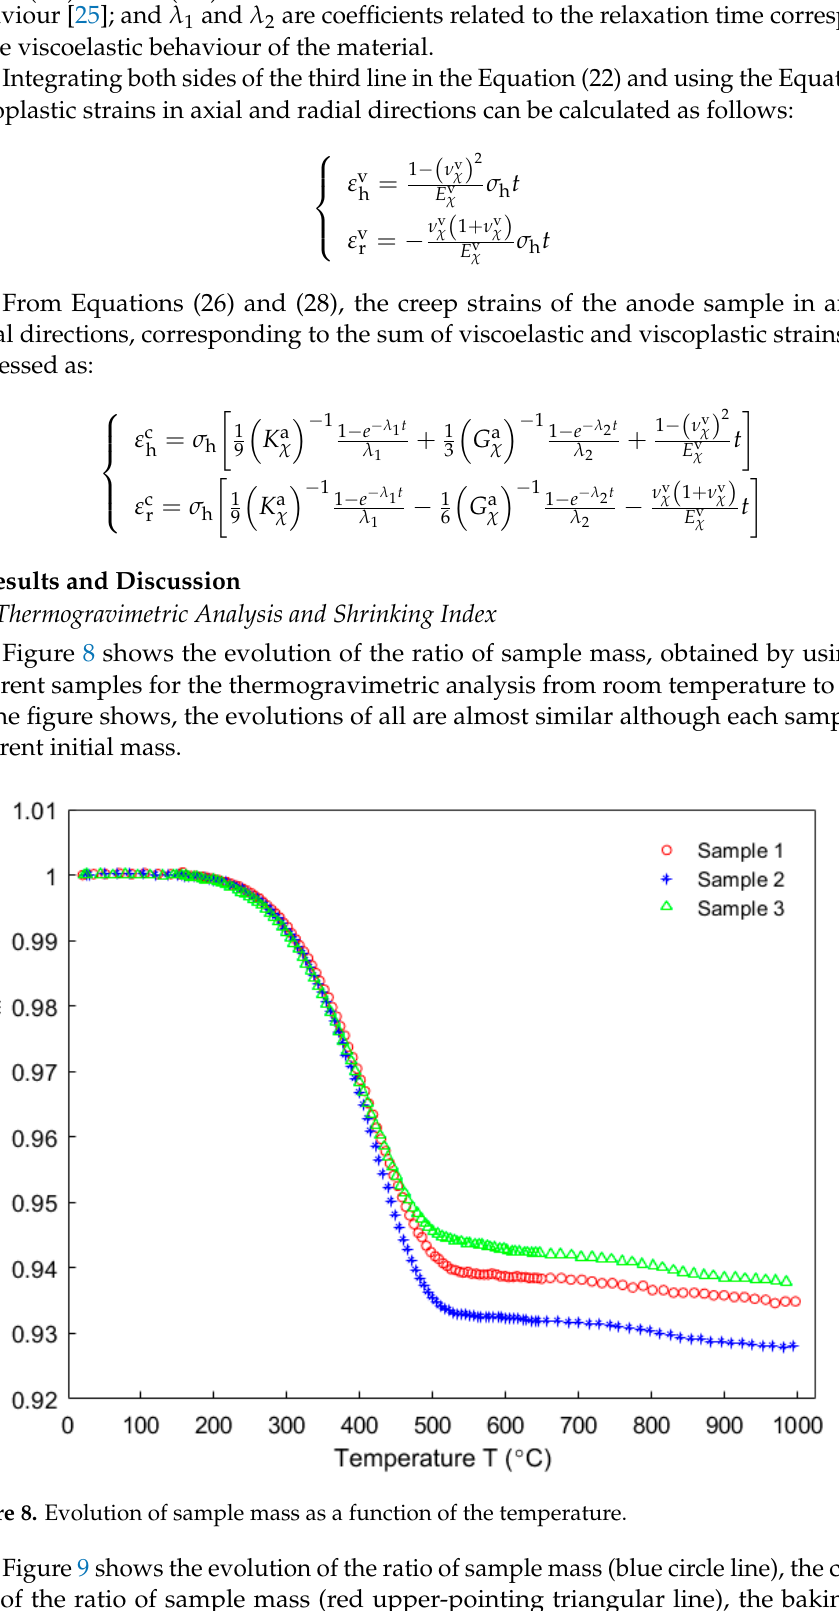
(black diamond line) and the modeling of baking index (green, cyan and magenta lines).